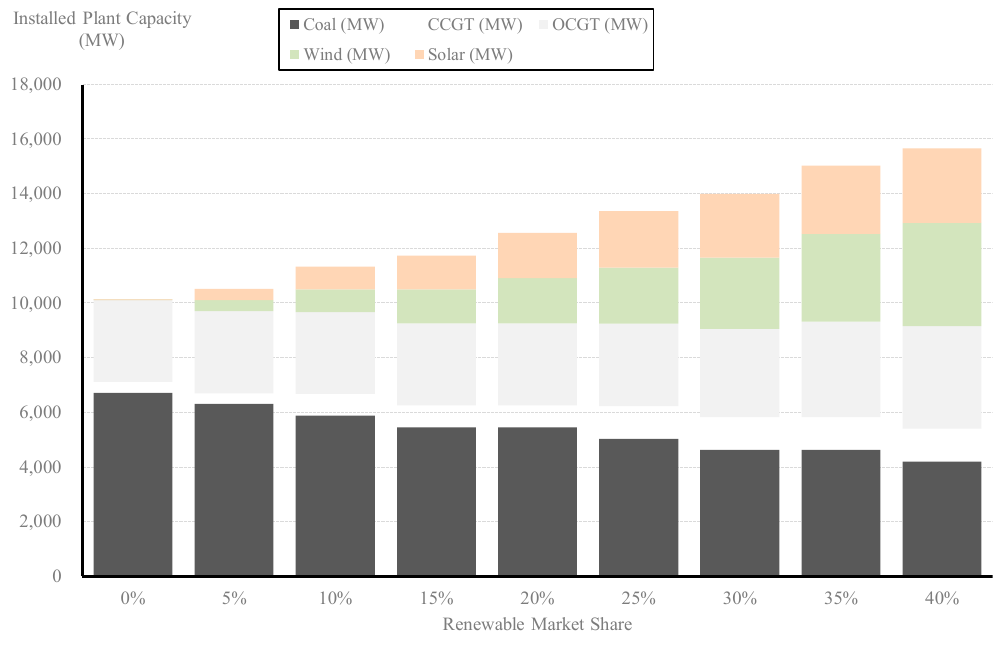
Figure 2. Installed plant capacity (MW).